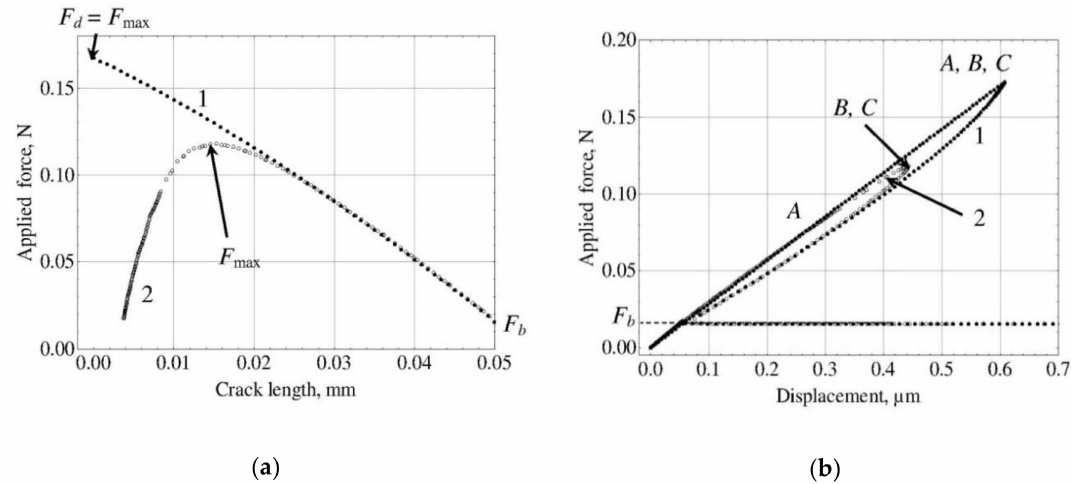
Figure 5. Force–crack length ( a ) and force–displacement ( b ) curves simulated for the glass fiber–epoxy matrix system. The embedded length is 50 µ m. Curve 1 corresponds to the equivalent cylinder; curve 2, to the real-shaped